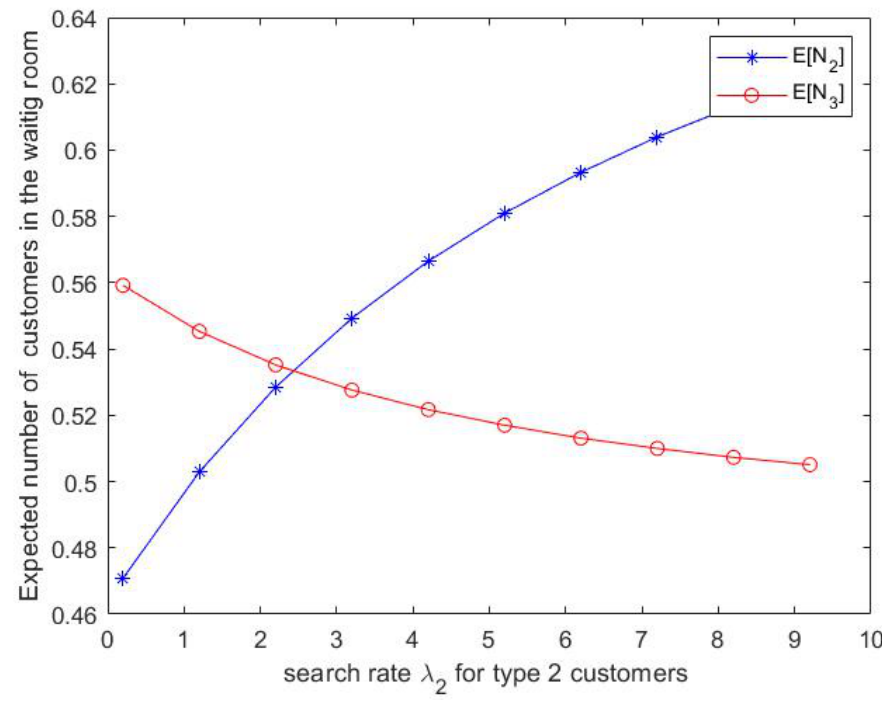
Figure 9. Effect of λ 2 on expected number of type 2,3 customers in the waiting room 2,3.